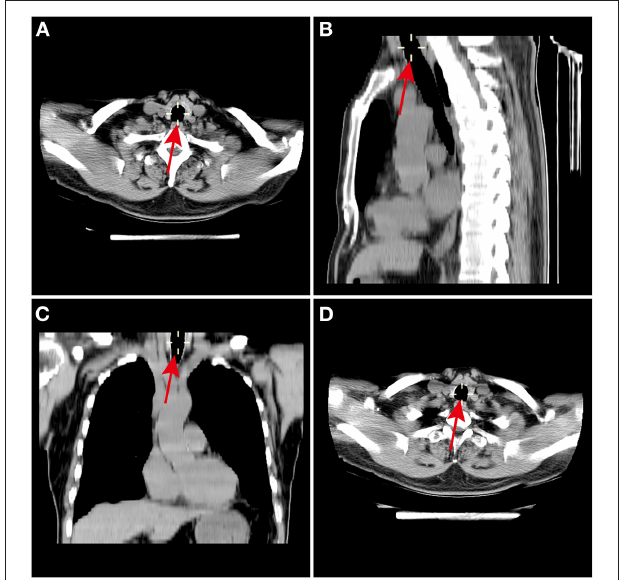
FIGURE 1 | Measurement of the cricoid cartilage using chest HRCT scan MPR. The MPR of the cricoid cartilage was performed using the (A) axial, (B) sagittal, and (C) coronal slices. The declination of TD-C was corrected in 3 dimensions to obtain a strictly orthogonal cut of the cricoid cartilage axis. (D) The TD-C were measured on the MPR at the lower border of the cricoid ring. TD-C, transverse diameter of cricoid cartilage.